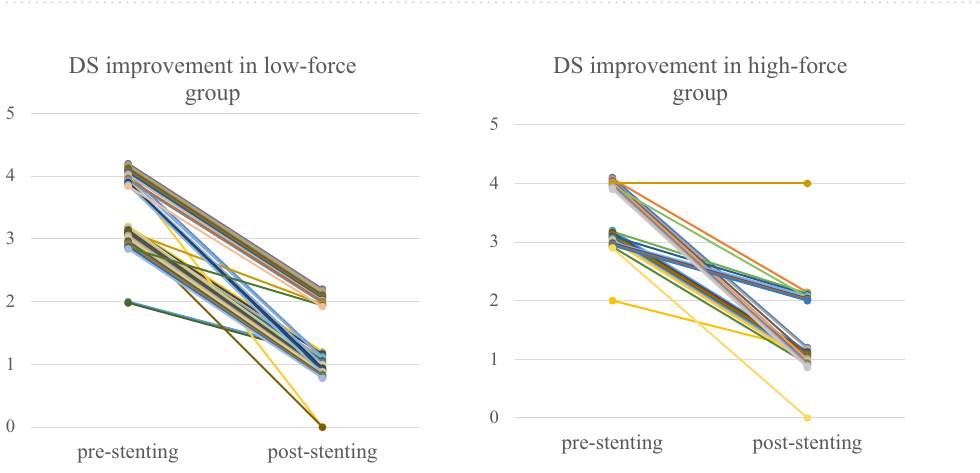
Table 3. Clinical factors associated with SAEs. Quantitative data was compared using Mann–Whitney’s U test. Univariate analysis was compared using Fisher’s exact test. Multivariate analysis was performed using logistic regression. Ae, abdominal esophagus; Ce, cervical esophagus; Lt, lower thoracic esophagus; Mt, middle thoracic esophagus; Ut, upper thoracic esophagus. a Stenosis was evaluated by an approximately 6 mm diameter nasal endoscope.